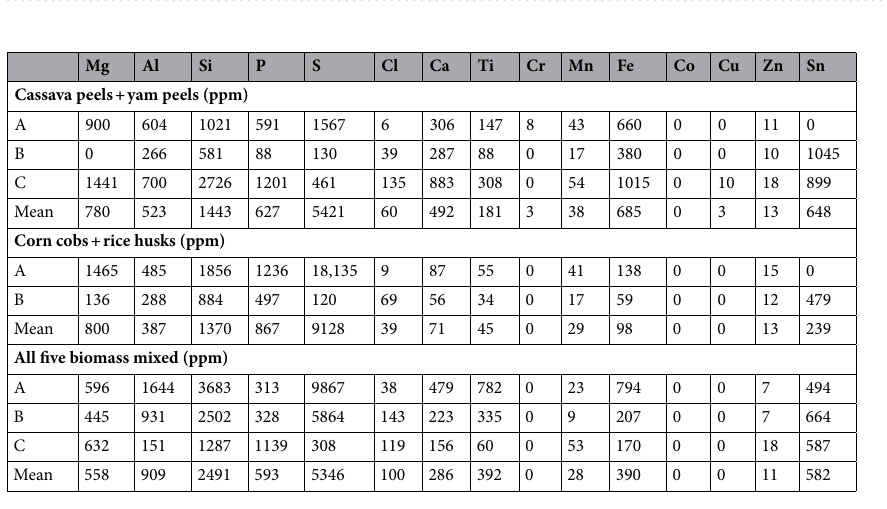
Table 9. Concentration of elements in cassava peels + yam peels mixed biomass, corn cobs + rice husks mixed biomass and the mixture of all five biomass samples after pretreatment. A = Acid pretreated. B = Alkaline Pretreated. C = Hydrothermal pretreated.